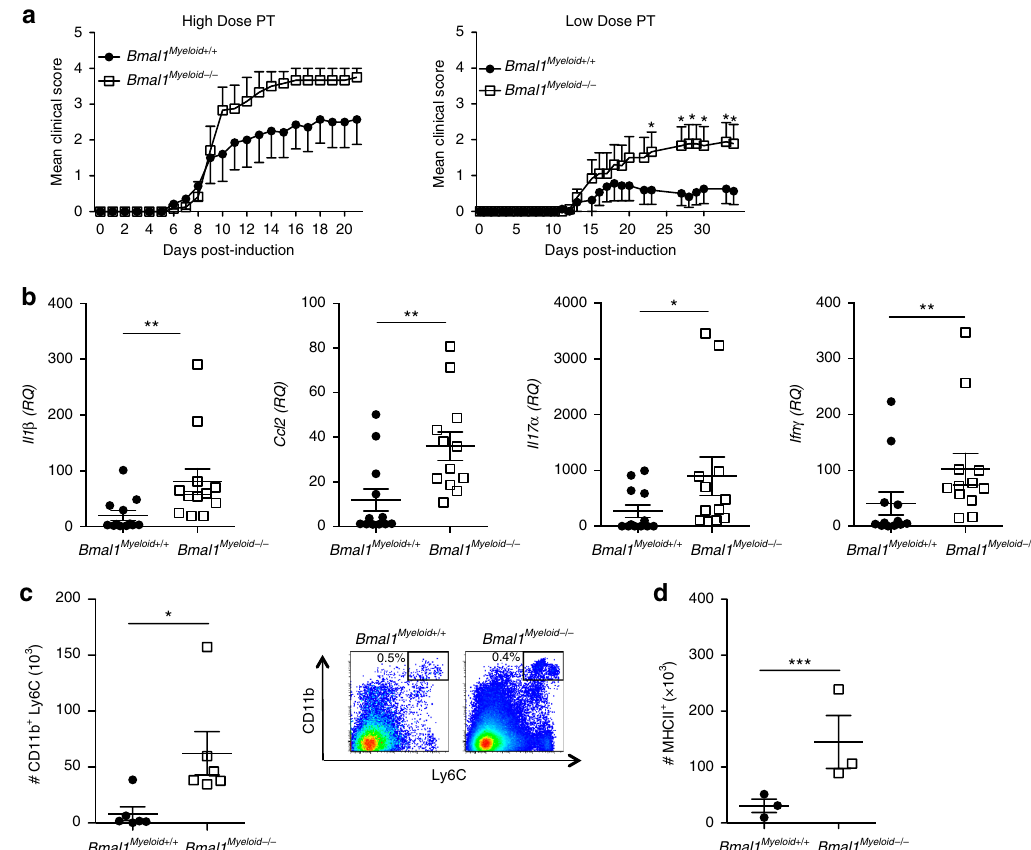
Fig. 2 Loss of Bmal1 from myeloid cells exacerbates EAE. a Bmal1 Myeloid + / + or Bmal1 Myeloid − / − mice were immunized to develop experimental autoimmune encephalomyelitis (EAE) with myelin oligodendrocyte glycoprotein (MOG 35 – 55 ) + complete Freund ’ s adjuvant (CFA) on d 0, and with either low dose pertussis toxin (PT) (125 ng/mouse) or high dose PT (250 ng/mouse) on d 0 and d 2. Mice were graded for EAE daily. Statistics by Kruskal – Wallis with at least 6 mice per group. b RT-PCR analysis of whole brain d 10 post induction of EAE examining Il1b , Ccl2 , Il17a and Ifng expression ( n = 9 – 12). c , d D 3 post immunization draining lymph nodes (LN) were isolated from Bmal1 Myeloid + / + or Bmal1 Myeloid − / − mice and stained ex vivo for CD3, CD11b, Ly6C and MHCII, gating on live CD3 − cells ( n = 3 – 6). Statistics were performed by Mann – Whitney U test ( b – d ). All data presented as means ± standard error of the mean (SEM). RQ relative quanti fi cation. * p < 0.05; ** p < 0.01; *** p <